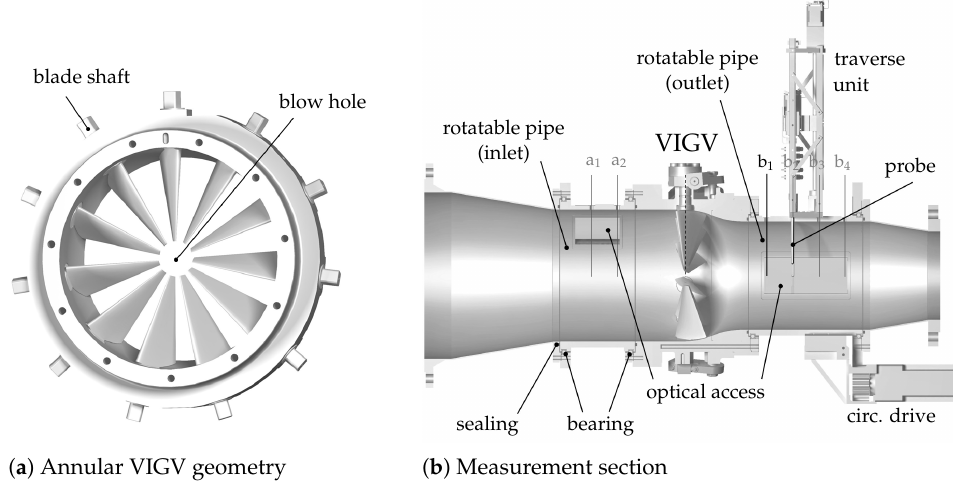
Figure 1. Design of the VIGV and the measurement